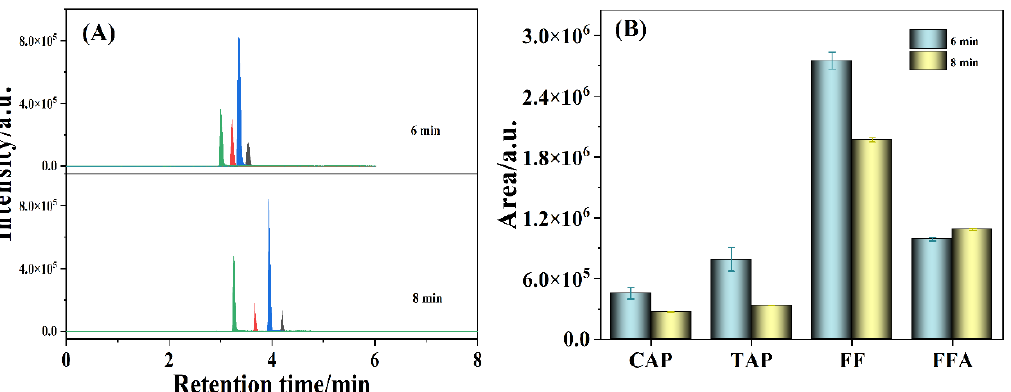
Figure 4. The chromatograms ( A ) and histograms ( B ) with error bar of 20 ng/mL CAP, TAP, FF, and FFA under different detection times. The peaks from left to right: FFA, TAP, FF, and CAP. Overall, the measurement of the amphenicol residues was performed on a 100 mm F5 column with the mobile phase of 1 mM AMA for 6 min. Figure S2 shows the chromatograms of 0.1 µ g/L standard solution of amphenicols detected under the optimal